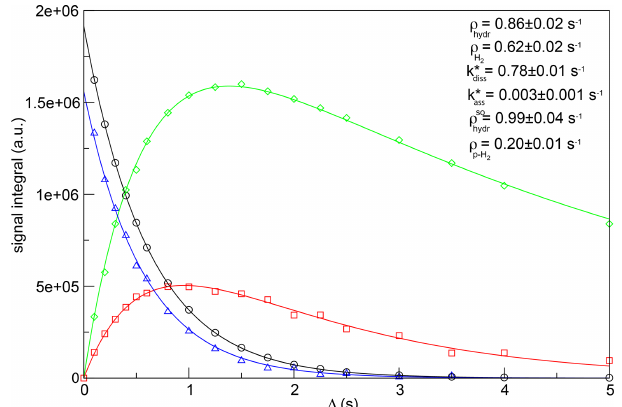
Figure 4. Simultaneous fit as a function of the relaxation period (cid:49) of the signal integrals of hydrides and H 2 derived from the experimental data of Fig. 3 to determine the longitudinal magne- tization decay rate (black circles), hydride dissociation rate (red squares), p-H 2 association rate (green diamonds) and longitudinal spin order decay rate (blue triangles) in the asymmetric complex [Ir(IMes)(H) 2 (IQ)(mtz) 2 ]Cl. The values of the hydrogen dissocia- tion and association rate constants and the hydrogen/hydrides’ re- laxation rates are indicated. The experimental data and the fitting curves have been rescaled to the same number of scans for this